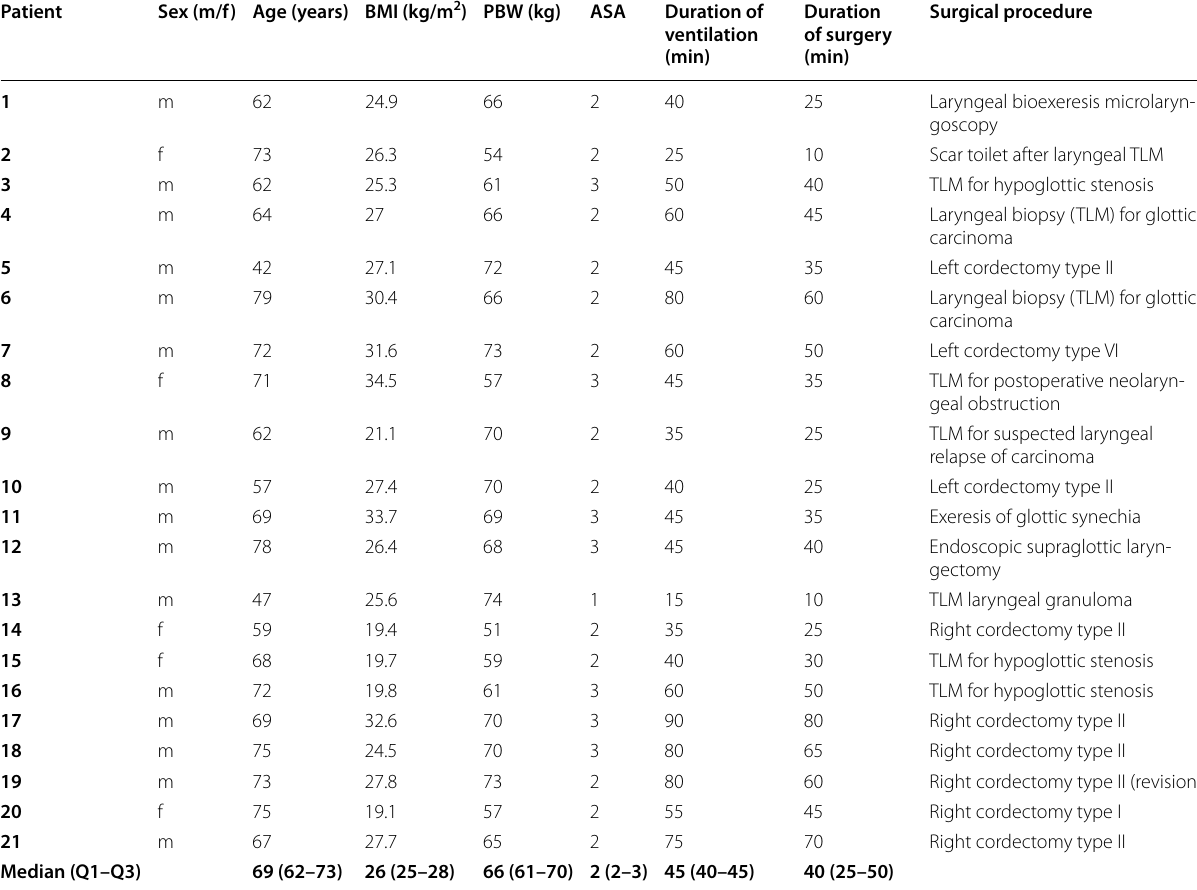
Table 1 Patient characteristics and surgical procedures Patient